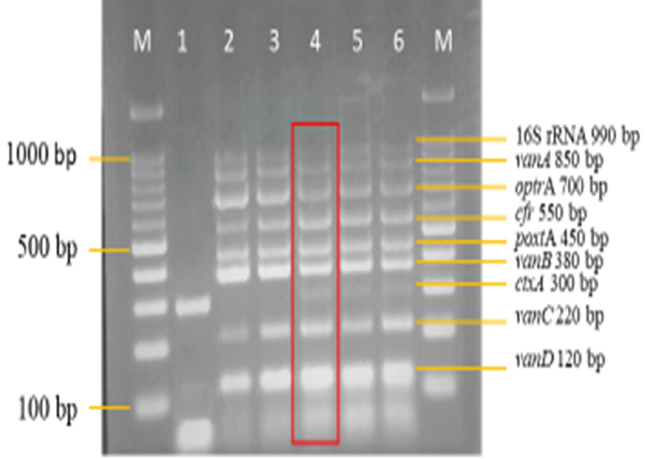
Figure 3. MgCl 2 concentration optimization in the multiplex PCR. A concentration of 2.5 mM on lane 4 from a range of concentration (1.5–3.5 mM) was selected as the optimum concentration. Lane M: DNA ladder 100 bp plus. Lane 1: Negative control with ctxA (Internal control). Lane 2: 1.5 mM of MgCl 2 . Lane 3: 2.0 mM of MgCl 2 . Lane 4: 2.5 mM of MgCl 2 . Lane 5: 3.0 mM of MgCl 2 . Lane 6: 3.5 mM of MgCl 2 .